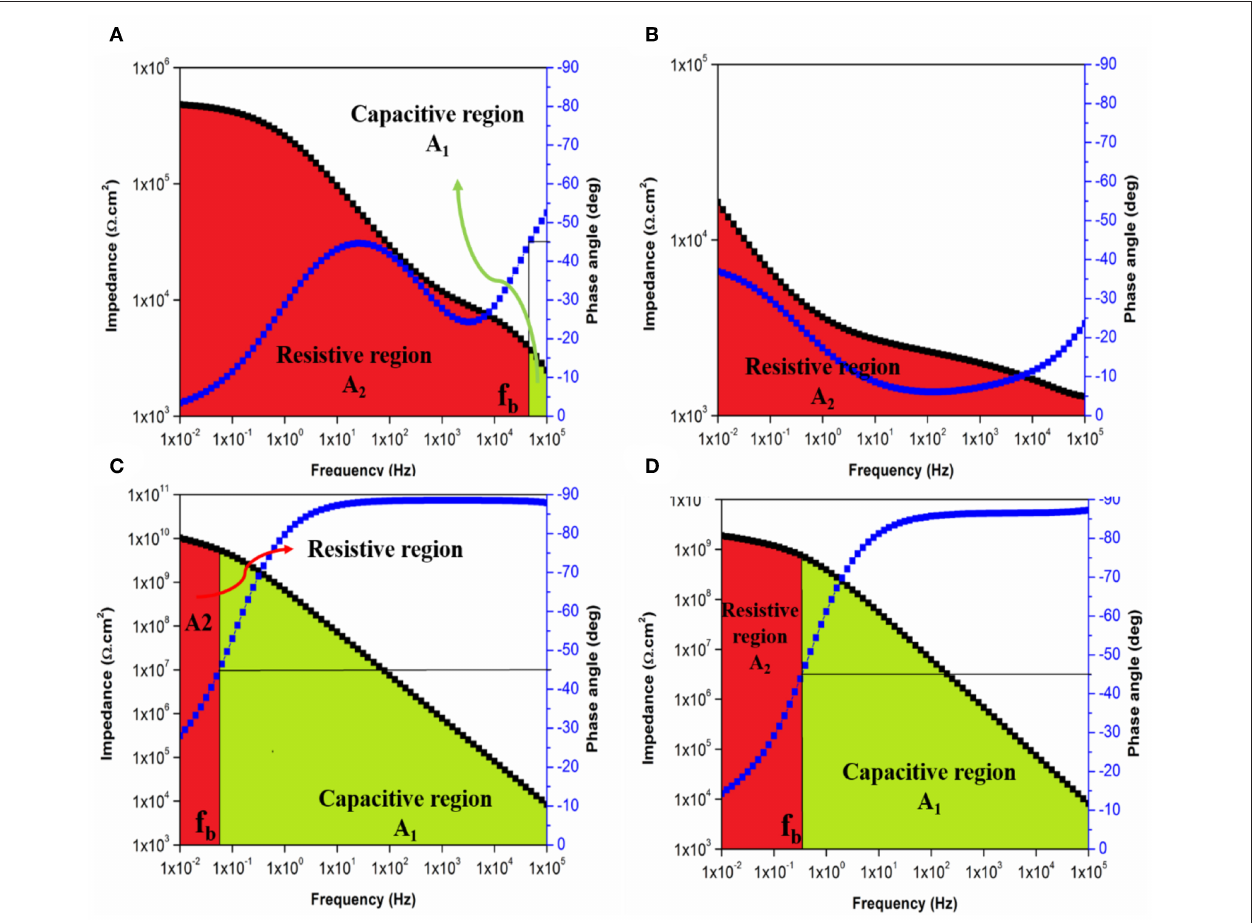
FIGURE 12 | Bode plot with breakpoint frequency determination of E coating system after (A) 1 day and (B) 30 days and of ET1 coating system after (C) 1 day and (D) 30 days of immersion with the corresponding capacitive (A 1 ) and resistive (A 2 ) regions.